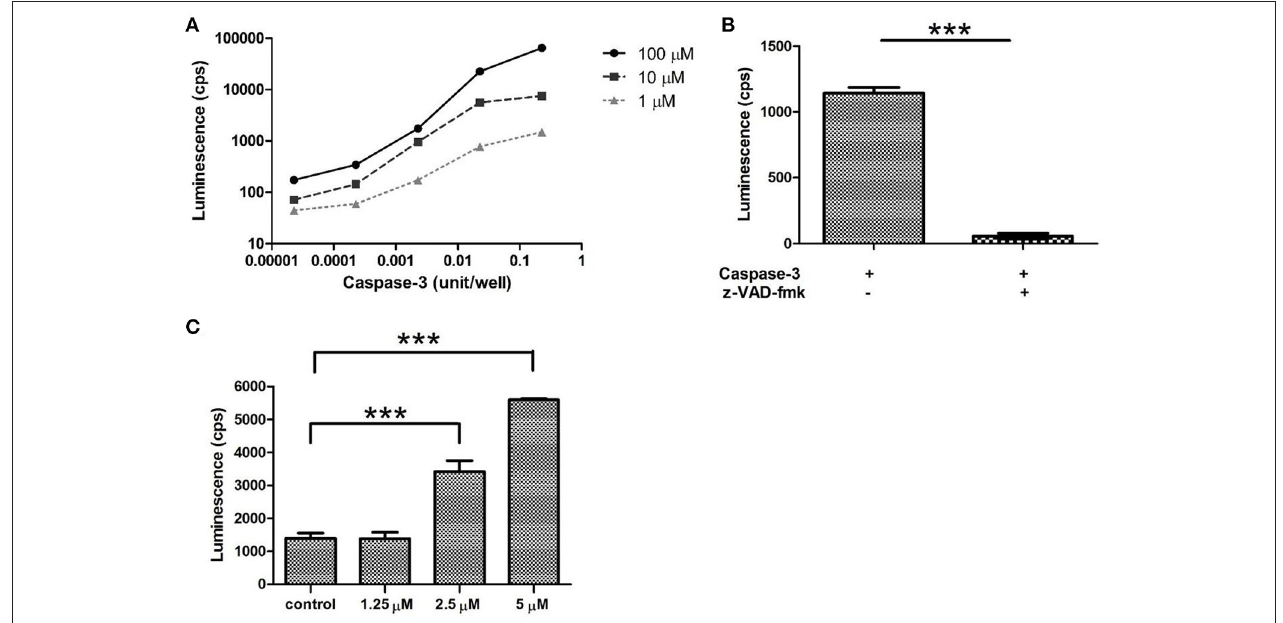
FIGURE 5 | Luminescence is proportional to caspase activity and N -Z- DEVD-aLuc concentration. (A) Recombinant human caspase-3 (227 mU to 22.7 µ U) and N -Z-DEVD-aLuc (100 to 1 µ M) were titrated and assayed for 45min. (B) The effect of the pan-caspase inhibitor Z-VAD-fmk was tested in equimolar ratio of N -Z-DEVD-aLuc at 10 µ M with 2.27 mU/reaction caspase-3. (C) Caspase-3 and -7 activation induced by the curcumin analog C150 (5–1.25 µ M) on A549 cells was detected by N -Z-DEVD-aLuc, control corresponds to untreated sample. The results are shown as arithmetic mean values of three samples ± SEM. Anyhow, SEM values are too small to be visible on the logarithmic scale of Figure 5A . *** p < 0.001.